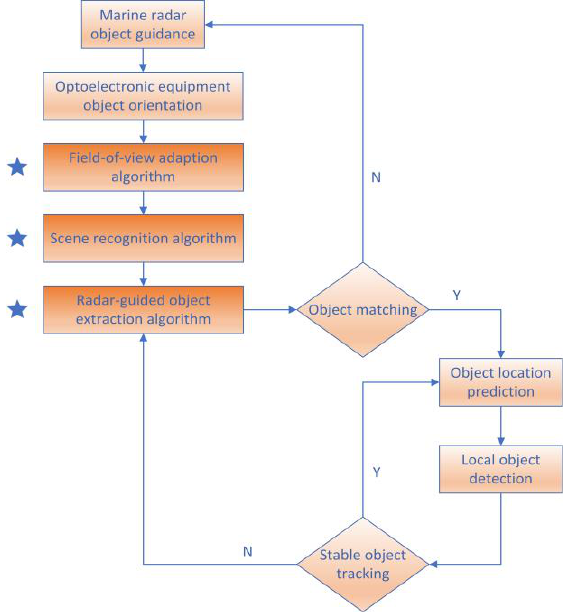
Figure 17. Flow chart of the USV object tracking.